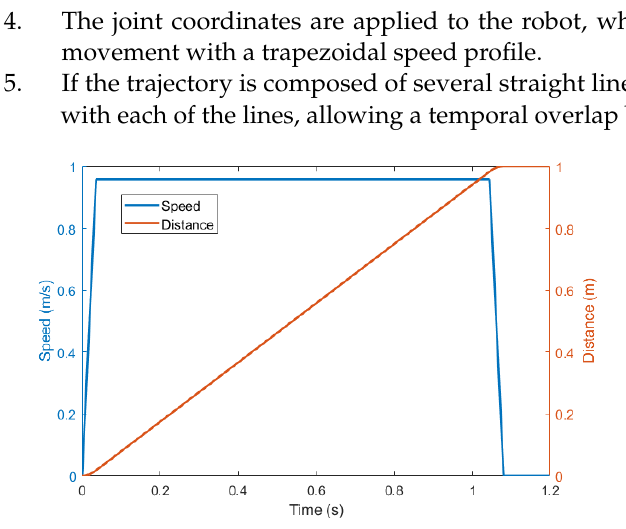
Figure 6. Trapezoidal speed